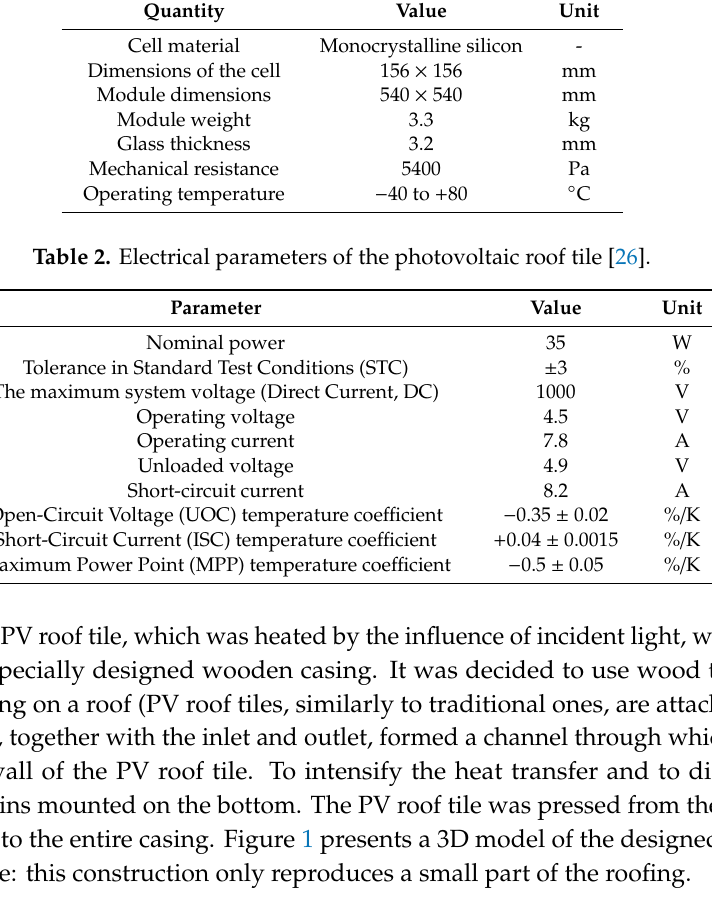
Table 1. Data of the photovoltaic (PV) roof tile construction [26].